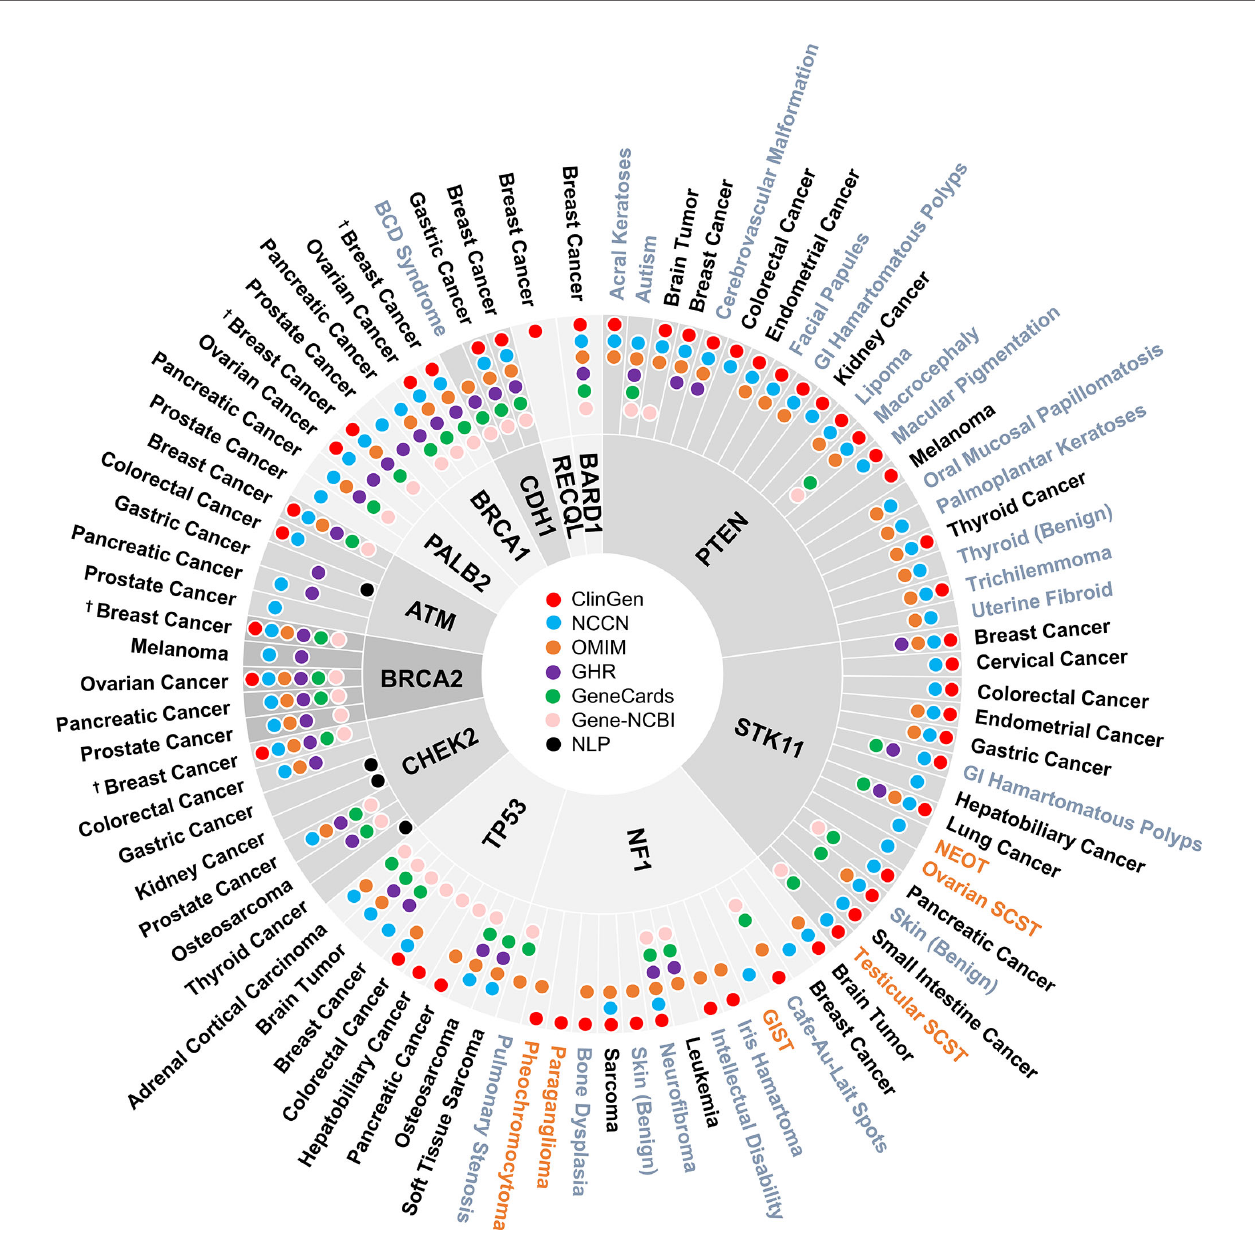
FIGURE 2 | Disease spectrum of breast cancer susceptibility genes. “†” refers to both female and male breast cancer. The three colors represent malignant disease (black), benign disease (grey), and borderline disease (orange), respectively. NLP, natural language processing; GI, gastrointestinal; BCD, blepharocheilodontic syndrome; SCST, sex cord-stromal tumor; GIST, gastrointestinal stromal tumor; NEOT, non-epithelial ovarian